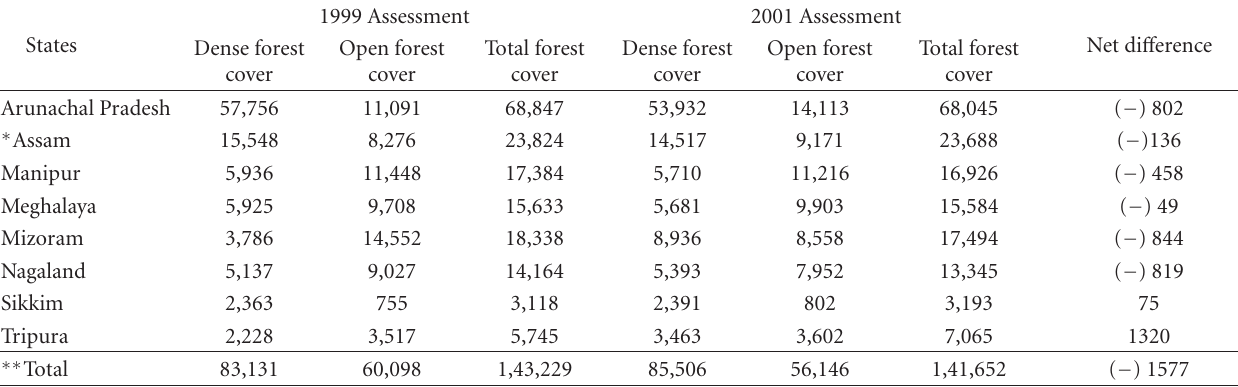
Table 1: Trends of forest loss/gain (km 2 ) in NEH